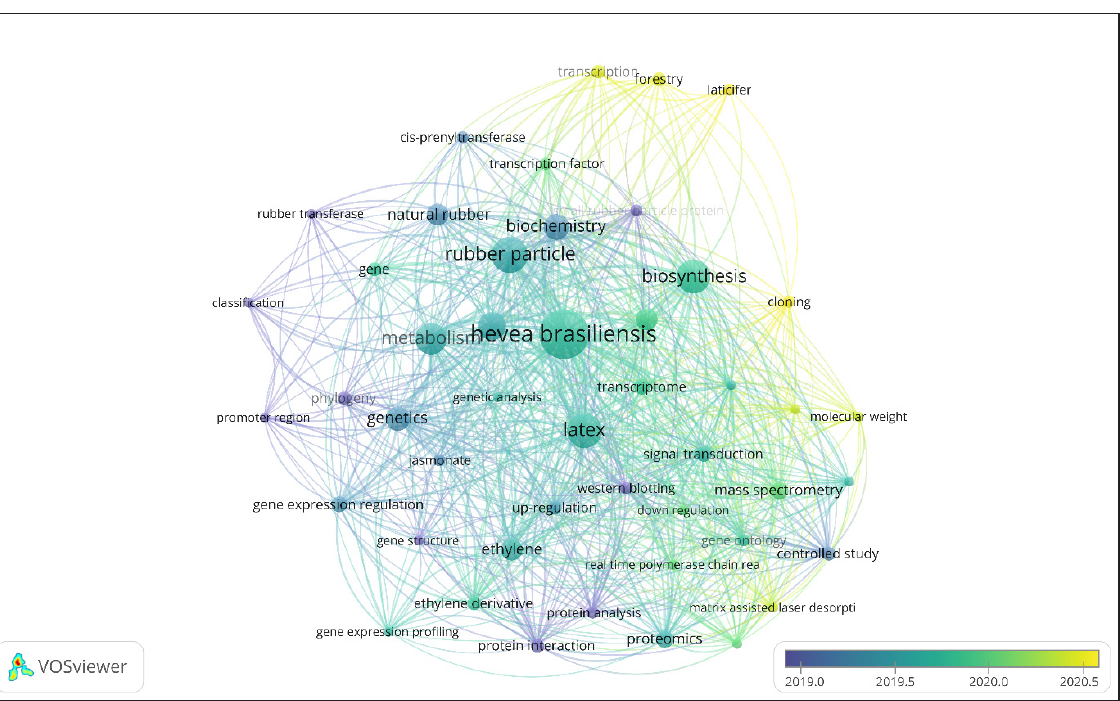
Figure 4. Overlay map of keywords related to the physiological mechanism using three minimum occurrences threshold from 41 papers included in the analysis. The bigger circle indicates a higher frequency of appearance of the keyword. Lines show networks among